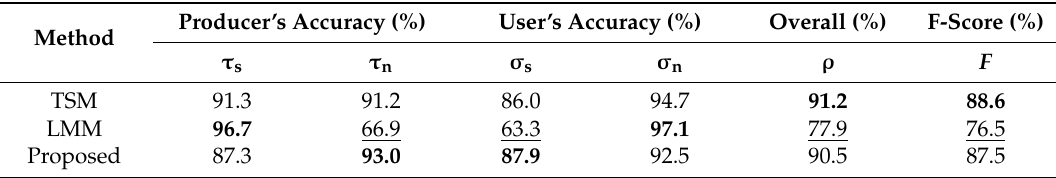
Table 5. Shadow detection accuracy measurements for test 2.